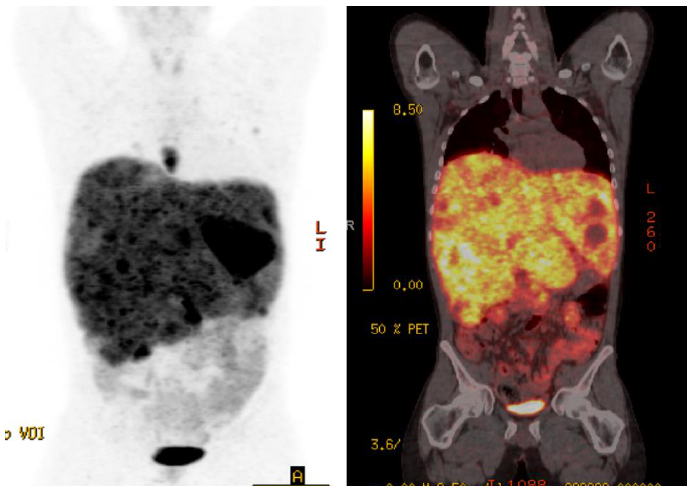
Figure 1. Case 1, Baseline Gallium-68 Dotatate PET-CT showed avid lesions in the lungs, posterior mediastinum, liver, retroperitoneal adenopathy, and diffuse liver and lung metastases. A total of two cycles of full dose Lutetium-177 Dotatate, 7.4 GBq (200 mCi) given every 8 weeks, were administered without complications or hemodynamic